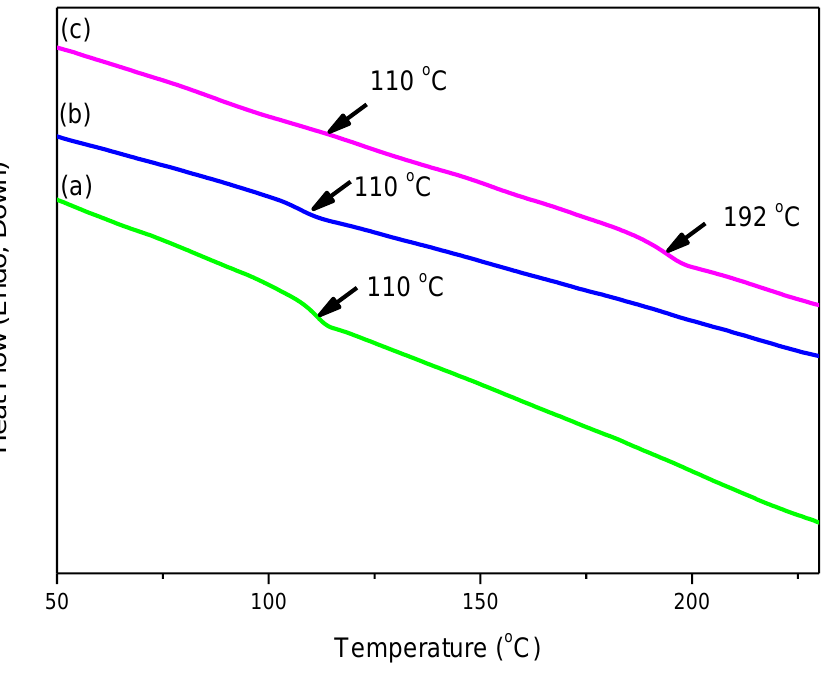
Figure 6. DSC thermograms of ( a ) PS-DDSQ-PS, ( b ) PtBuOS- b -PS-DDSQ-PS- b -PtBuOS, and ( c ) PVPh- b -PS-DDSQ-PS- b -PVPh.